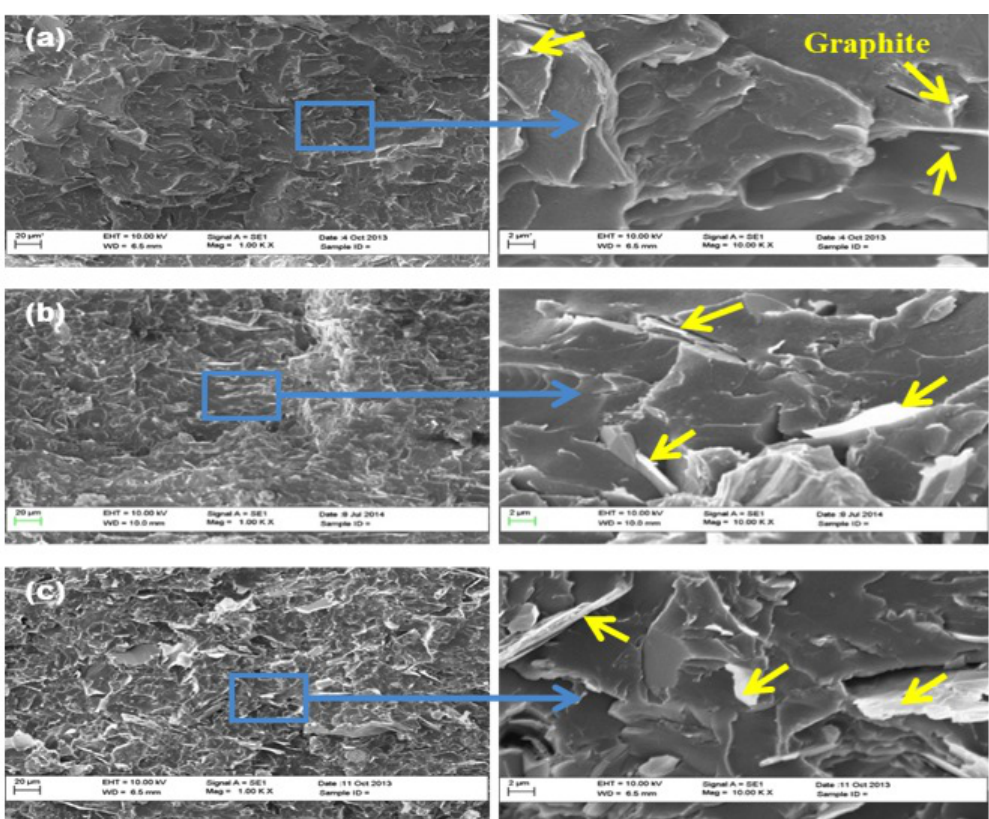
Figure 2. SEM images of PET/graphite micro-composites at low ( left ) and high magnifications ( right ): ( a ) 10 wt.%; ( b ) 15 wt.%; and ( c ) 20 wt.% of graphite. The arrows in the magnified images indicate the